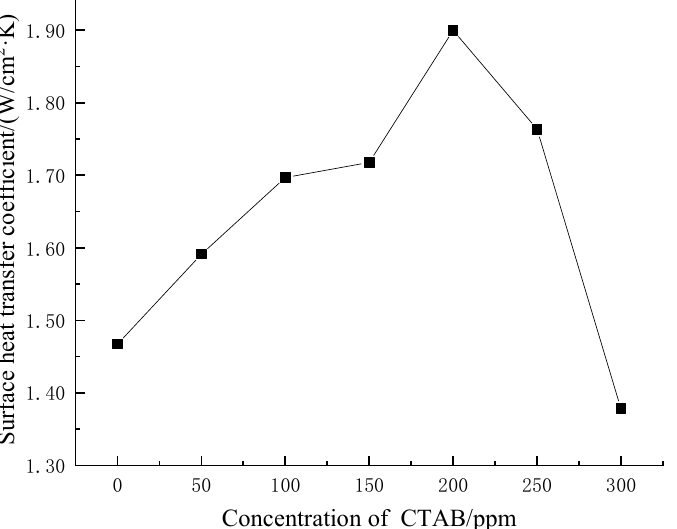
Figure 18. The steady-state heat transfer coefficients of spray cooling at different CTAB concentra-